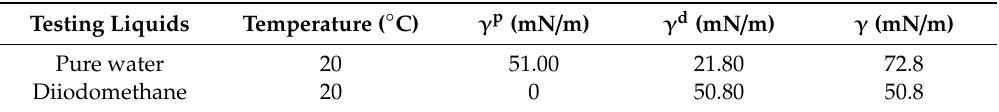
Table 3. Testing liquids for evaluating surface energy.